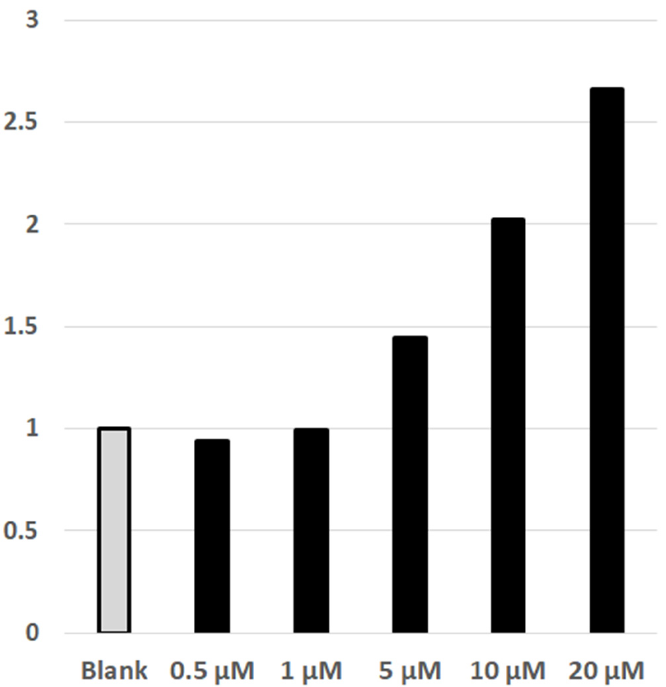
Figure 4. NFAT Luc reporter assay. The plot is normalized to the basal activity of the luciferase. Numbers indicate the fold of increase in luciferase activity upon inhibition of DYRK1A by PST-001.